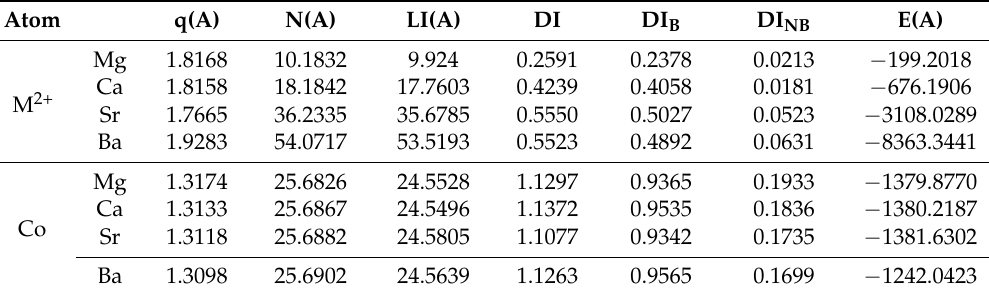
Table 4. Integrated properties of the M 2+ and Co atoms.